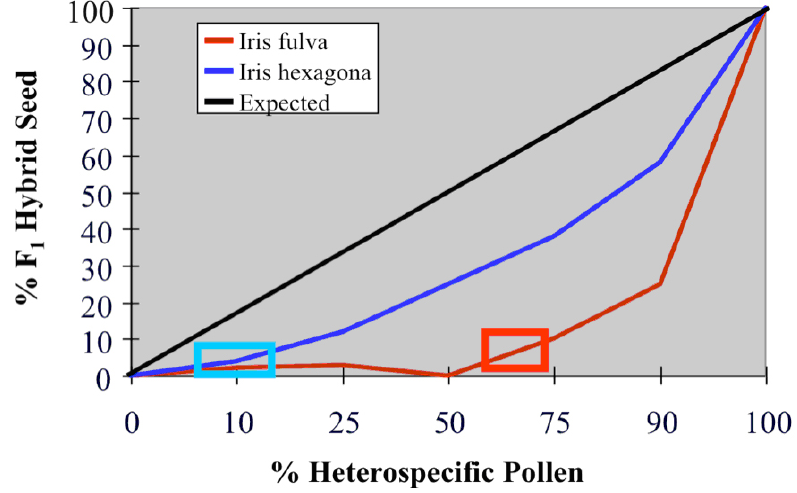
hybrid seeds produced by various mixtures of I. fulva and I. hexagona Figure 6 Percent F 1 pollen. The solid line illustrates the expected percentage of hybrid seeds assuming random fertilization. All the observed F percentages were significantly less than expected (except 1 for the 0% and 100% treatments, in which there were no mixtures of conspecific and heterospecific pollen). The blue and red rectangles indicate the percentage of heterospecific pollen necessary to increase significantly F hybrid formation above the 1 value of “0” in I. hexagona and I. fulva fruits, respectively. Note the much